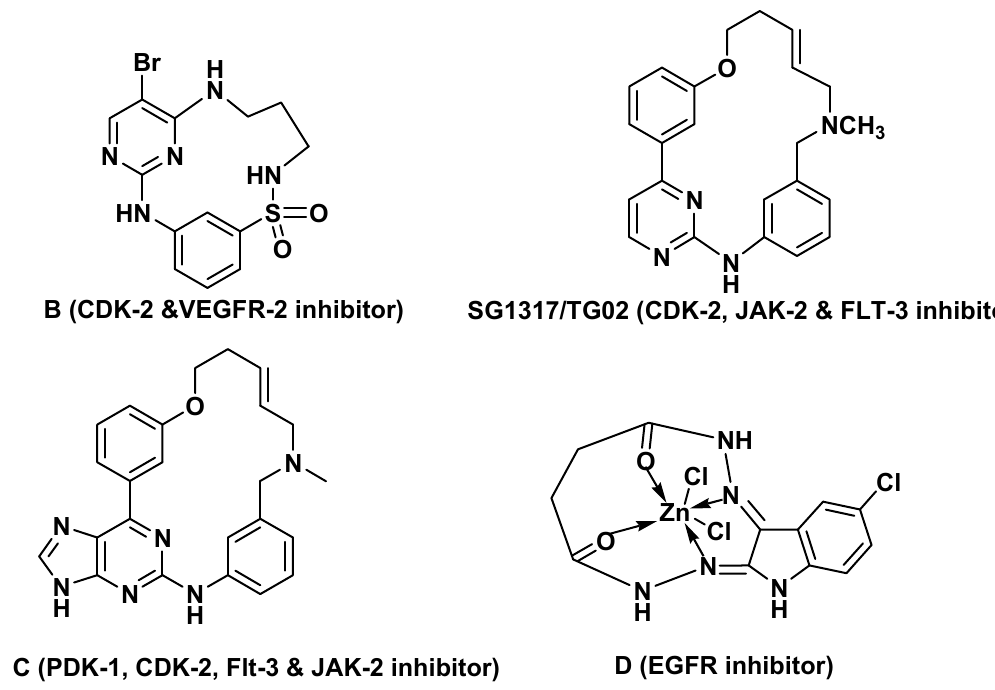
Figure 2. Reported and proposed macrocyclic conjugates with anticancer and different kinases inhibitory activity. inhibitory